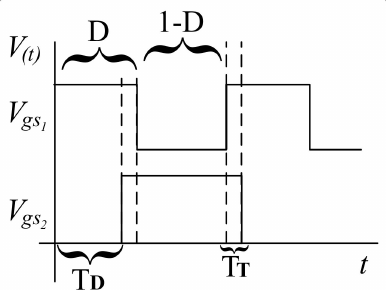
Figure 5. Overlapped signals in M 1 and M 2